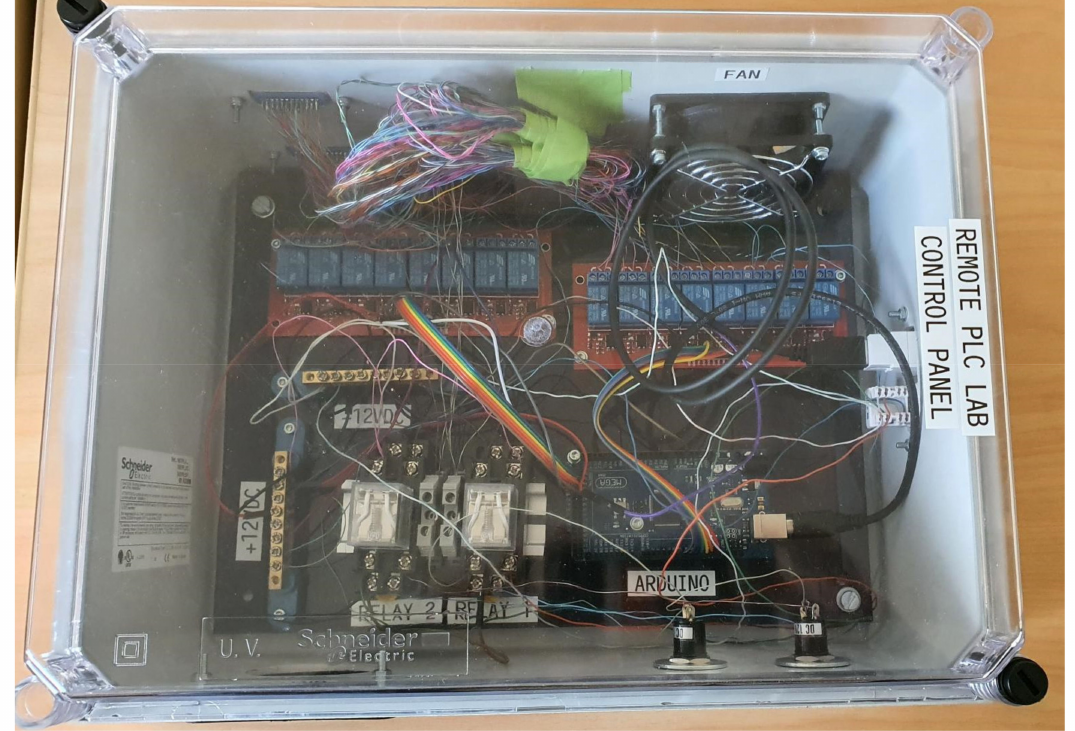
Figure 17. Fully assembled control